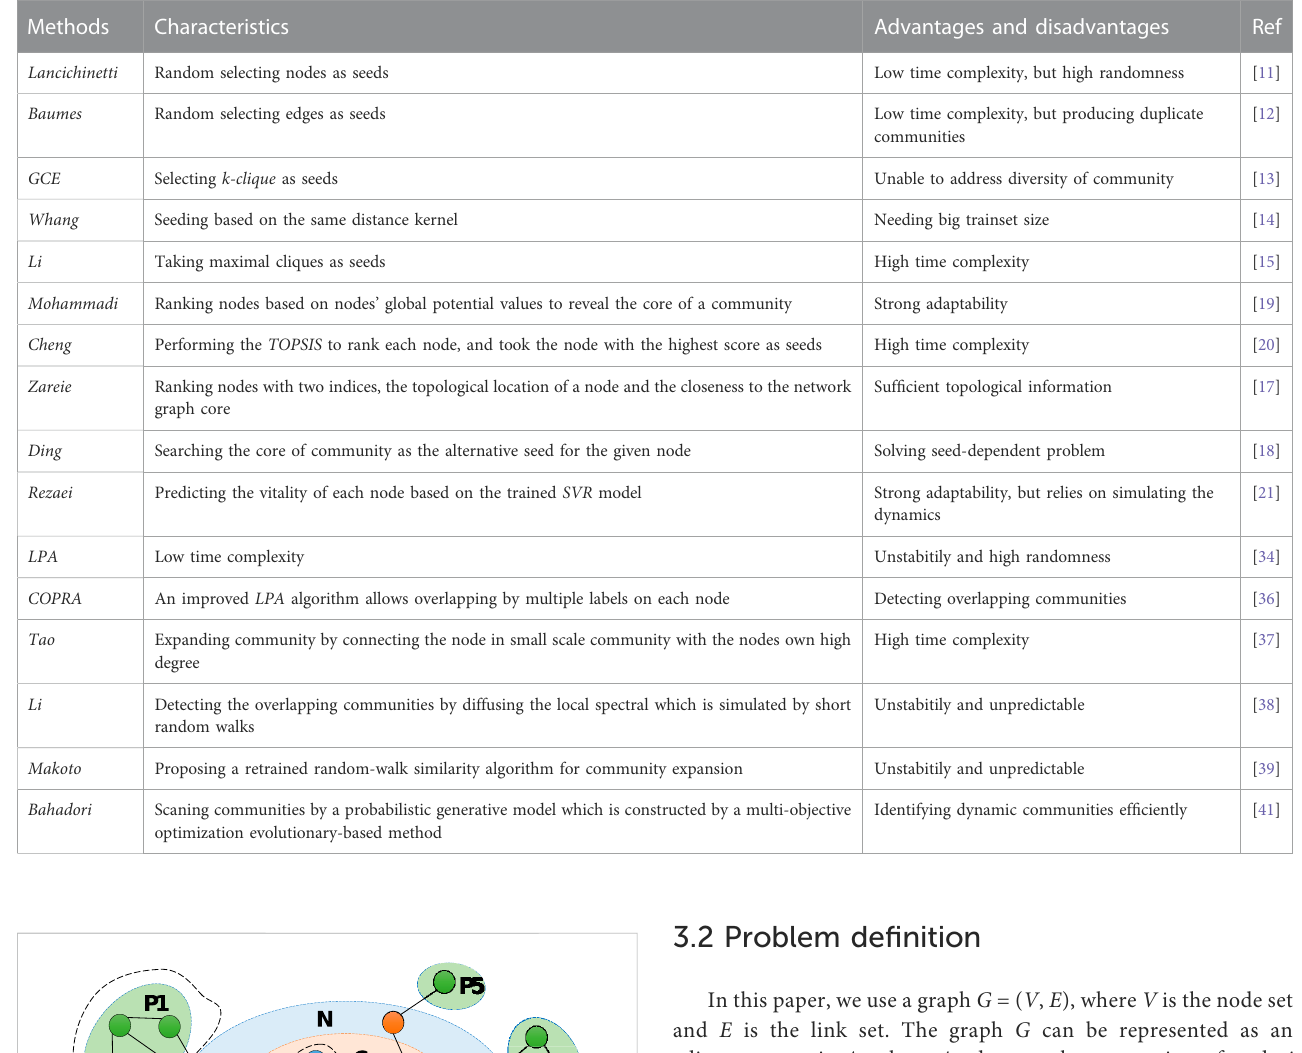
TABLE 1 Pros and cons of common methods.